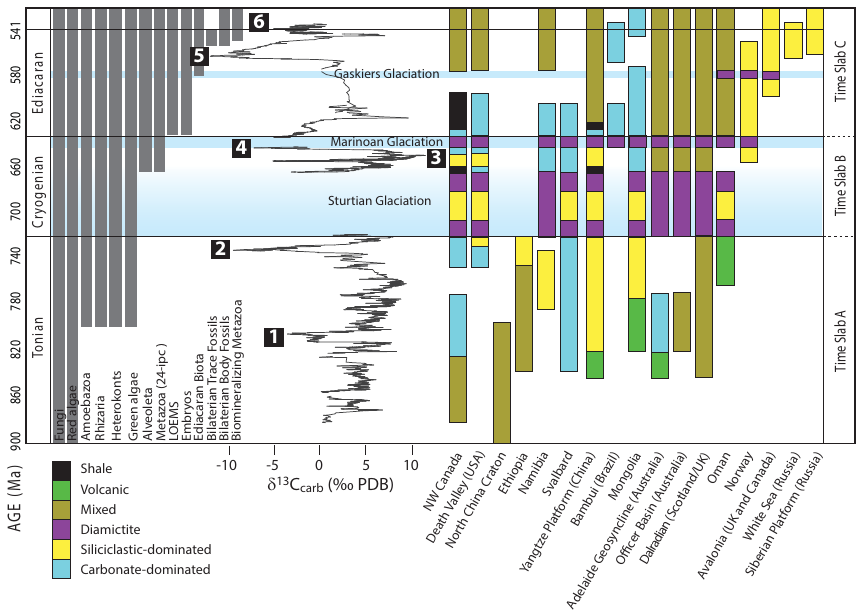
Figure 2. Schematic timeline showing major evolutionary events, a composited δ 13 C curve with numbered isotope anomalies (1 – Bitter Springs; 2 – Islay; 3 – Keele Peak; 4 – Trezona; 5 – Shuram; 6 – BASE) and an approximation of the stratigraphic distribution and dominant lithology type for a number of key Neoproterozoic successions that occur worldwide. Time slabs identified for drilling are shown on the